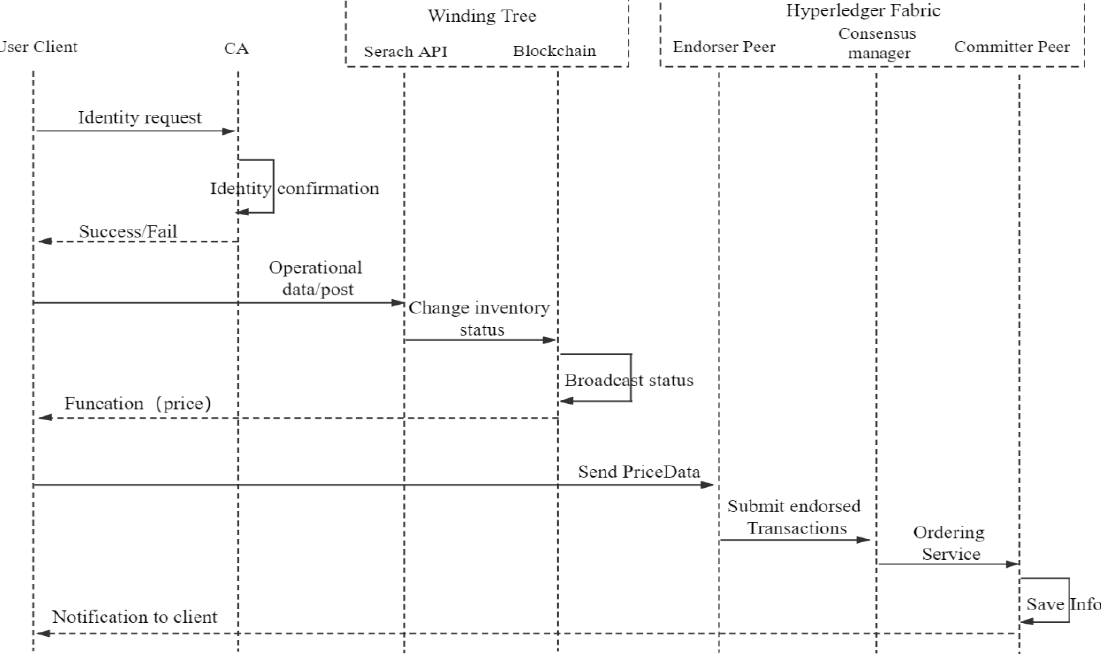
Figure 18. The transaction process of the proposed system.